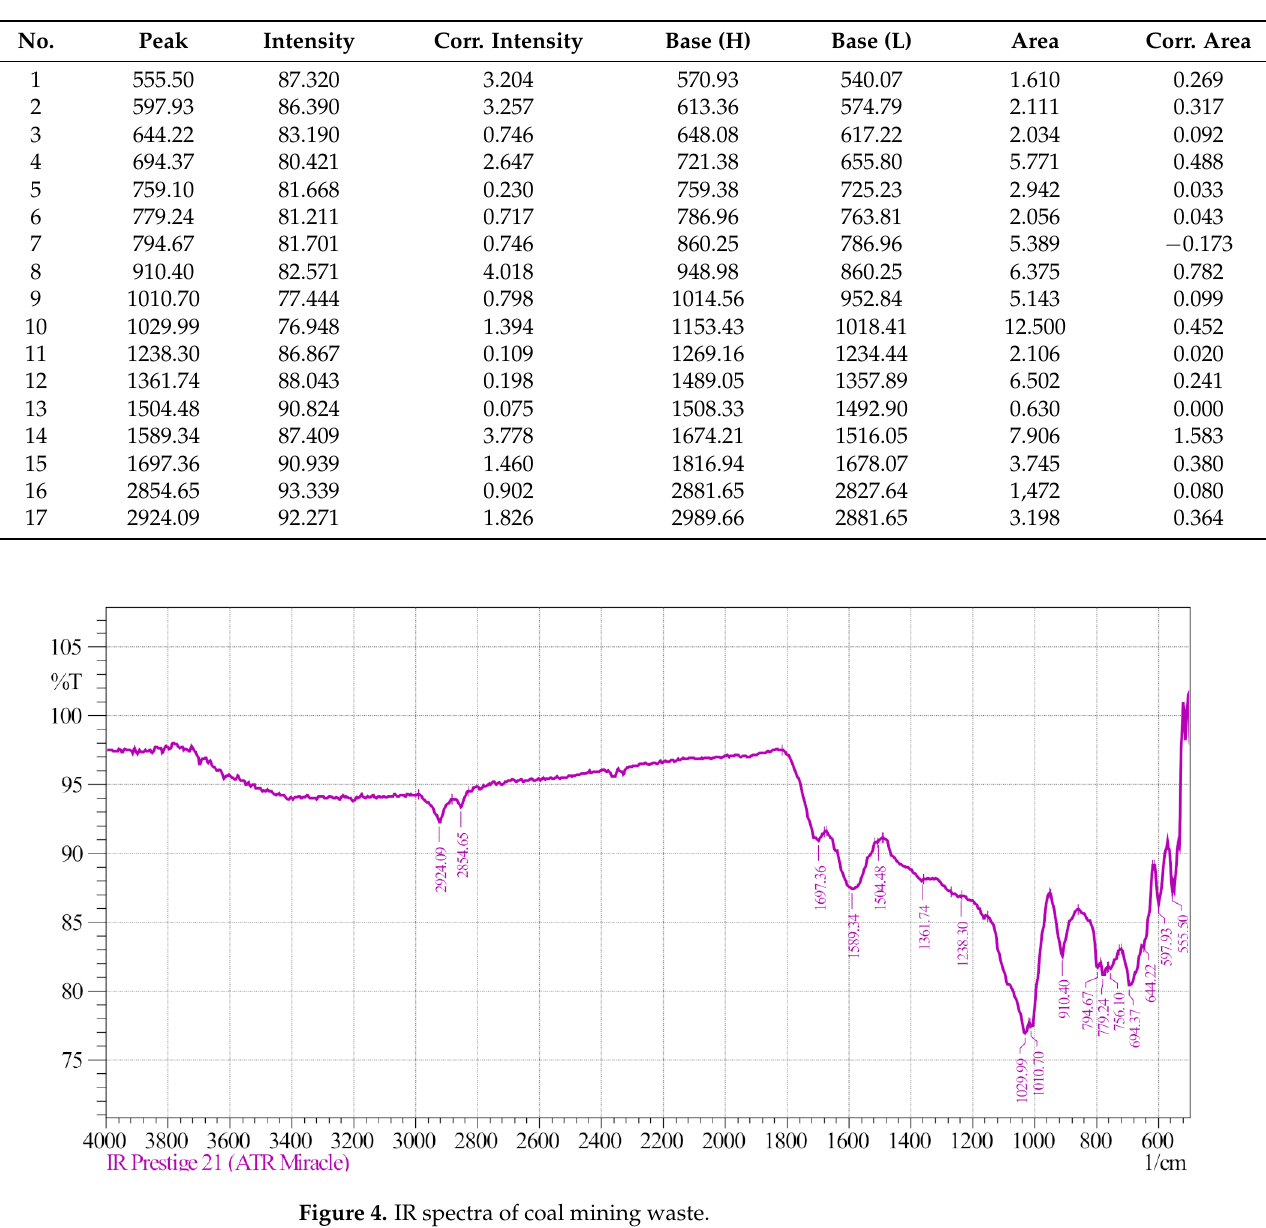
Table 3. Peaks of IR spectral analysis of coal mining waste.